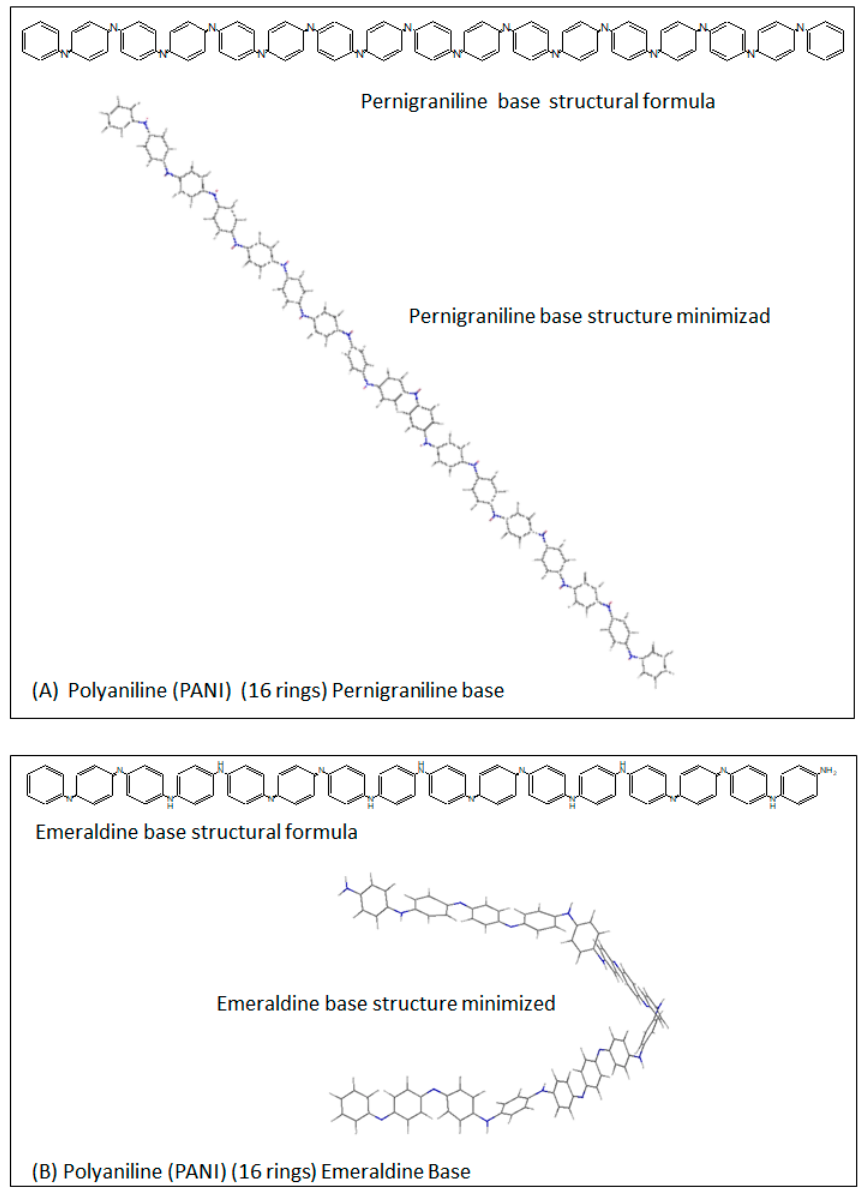
Figure 1. ( A ) Minimized (MM2) geometries of PANI oligomers (16 rings). ( A ) Pernigraniline base; ( B ) emeraldine base .